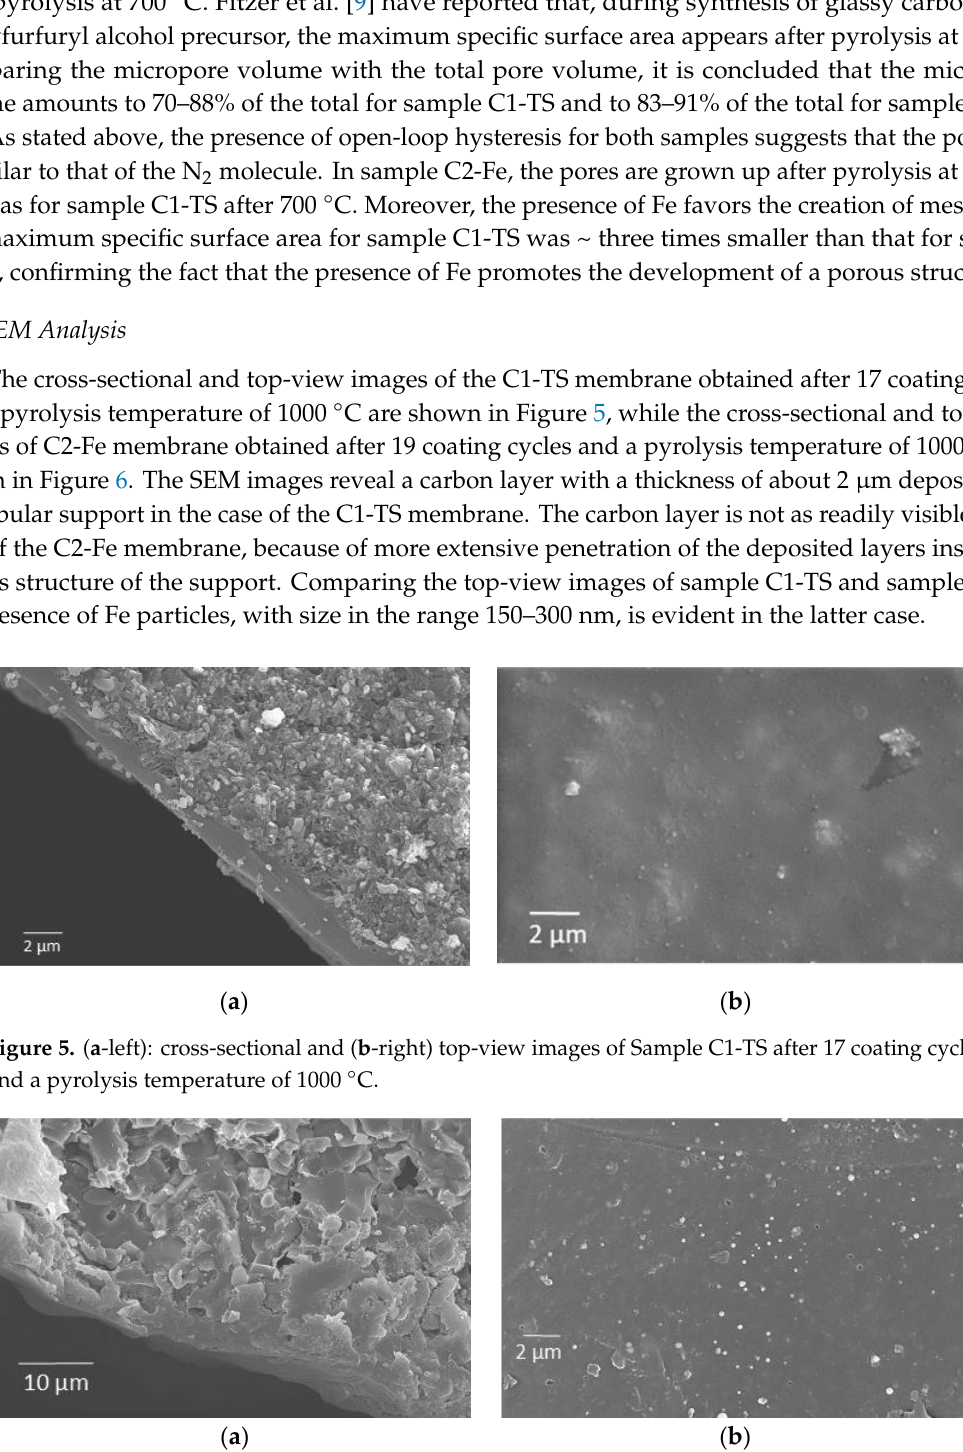
Figure 6. ( a -left) cross-sectional and ( b -right) top-view images of Sample C2-Fe after 19 coating cycles and a pyrolysis temperature of 1000 ◦